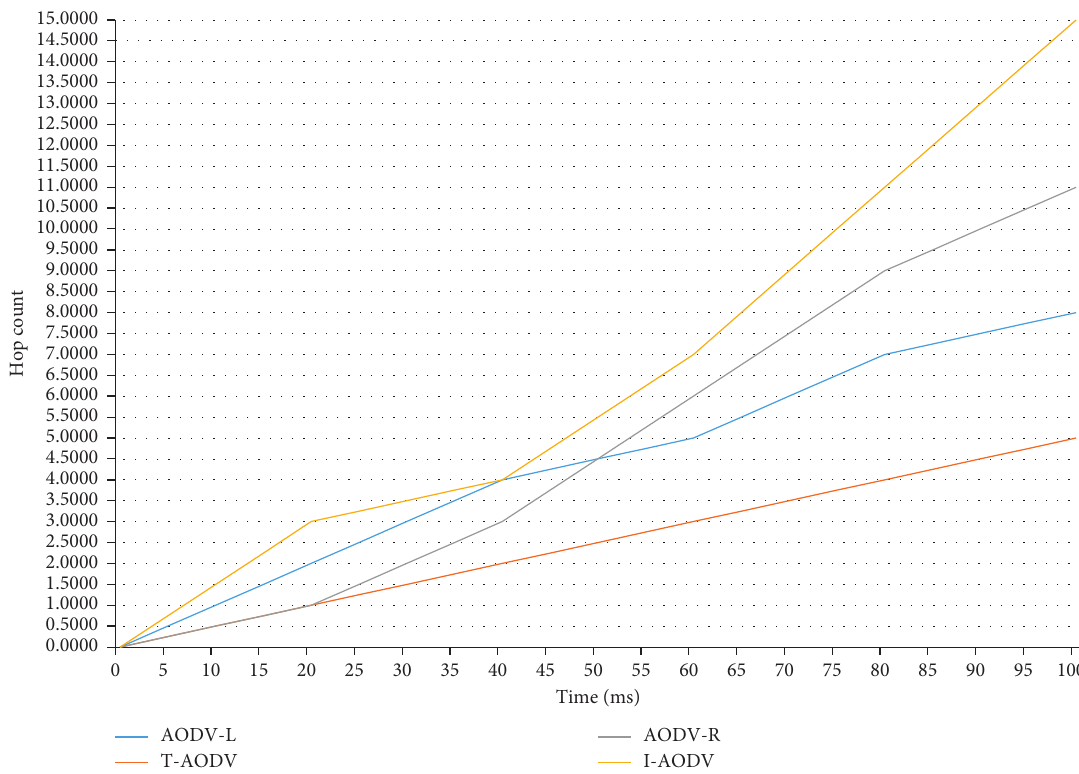
Figure 8: An average hop count of the network. Table 4: Average hop count for different networks.